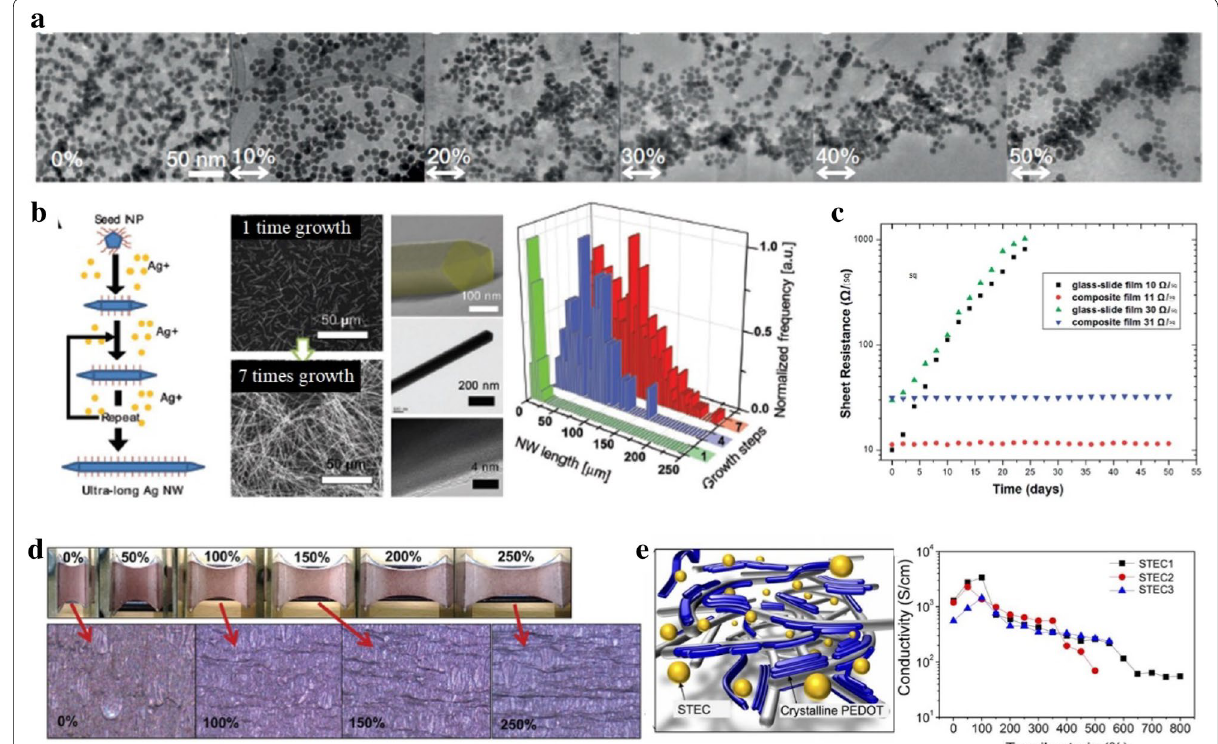
Fig. 3 a Self-organizing behaviour of Ag nanoparticles under strain. Reproduced with permission [81]. Copyright 2013, Nature Publishing Group. b Synthesis process for very long Ag nanowires, and images (middle) and the NW length distribution graph (right) of lengthened Ag nanowires formed by the SMG method. Reproduced with permission [62]. Copyright 2012, Wiley–VCH. c Sheet resistance versus time of CuNWs based films to show the oxidative stability. Reproduced with permission [82]. Copyright 2014, Royal Society of Chemistry. d Laser-nanowelded stretchable CuNW conductor. Reproduced with permission [84]. Copyright 2014, Wiley–VCH e Schematic illustration of the PEDOT/STEC (left). Conductivity change under strain for PEDOT incorporated with three different enhancers for stretchability and electrical conductivity (STEC) (right). Reproduced with permission [86]. Copyright 2017. American Association for the Advancement of